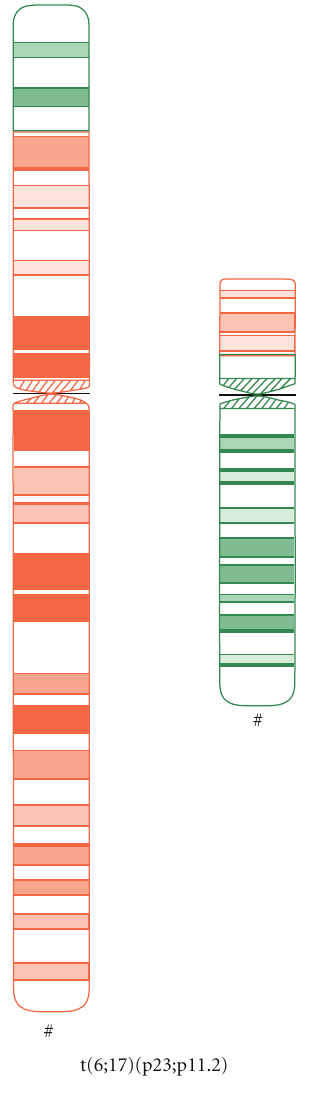
Figure 2: Idogram of the